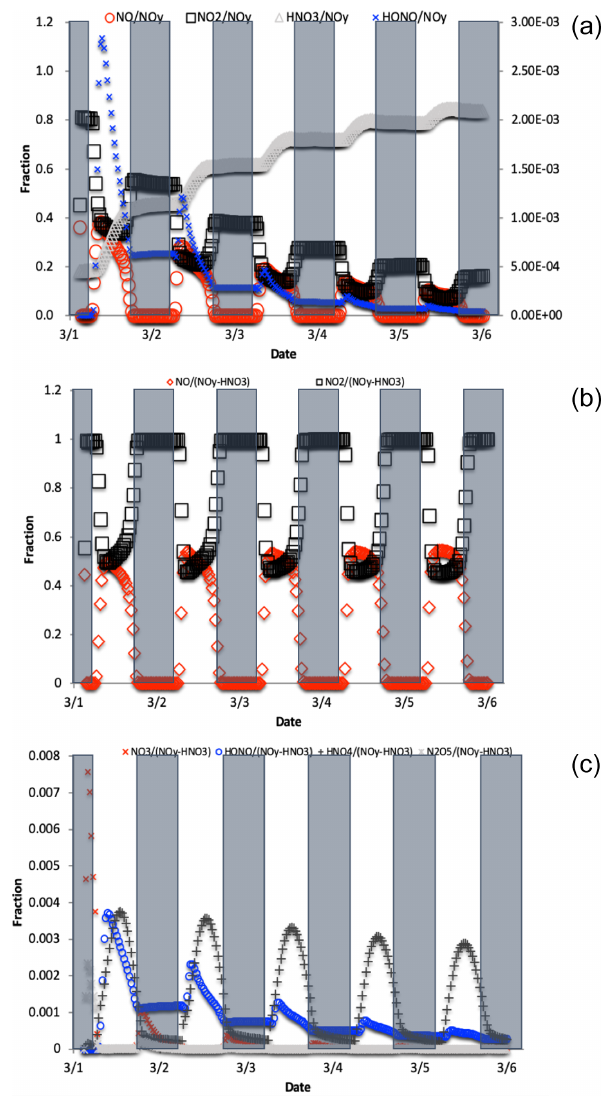
Figure 4. The change in f NO , f NO , f NO , and f HONO (right axis) 2 3 over the 5d simulation shows the transition from NO y as mostly NO x to predominately HNO 3 (a) . For reactive NO y (NO y –HNO 3 ) (b) caused by photolysis large diurnal changes in f NO and f NO 2 minimize the other f NO values, none of which exceeds 0.01 (c) y